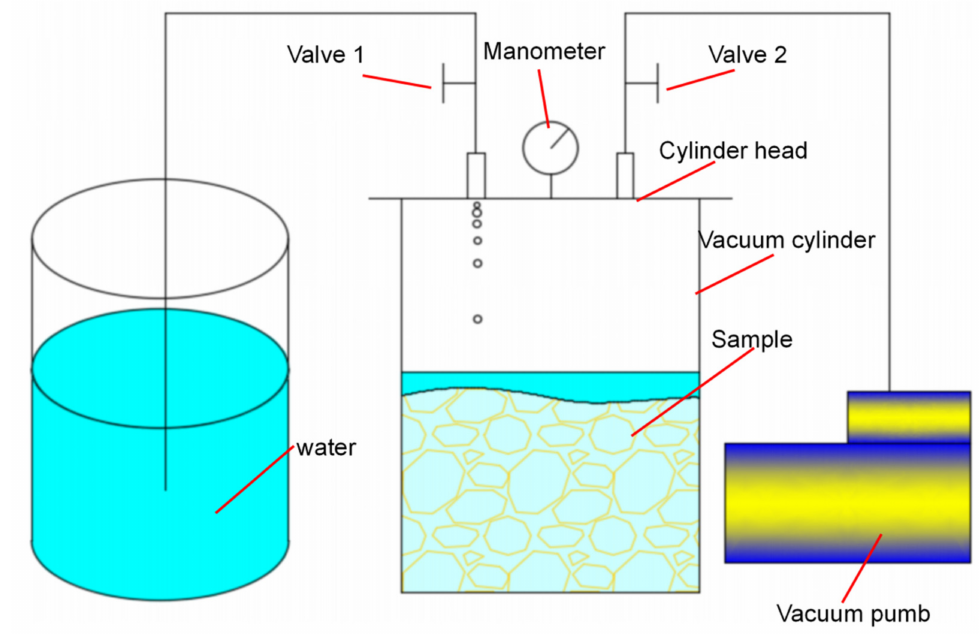
Figure 2. Schematics of preparing the sample for tests.